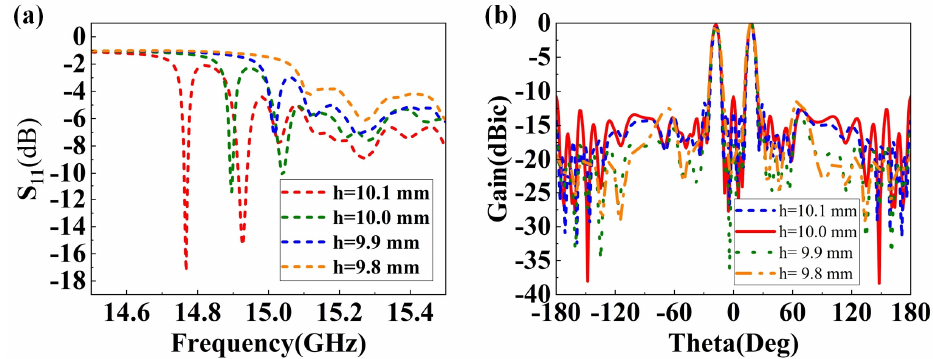
Figure 6. ( a ) Reflection coefficients with different cavity heights. ( b ) Normalized far-field patterns in the yx plane with different cavity heights.